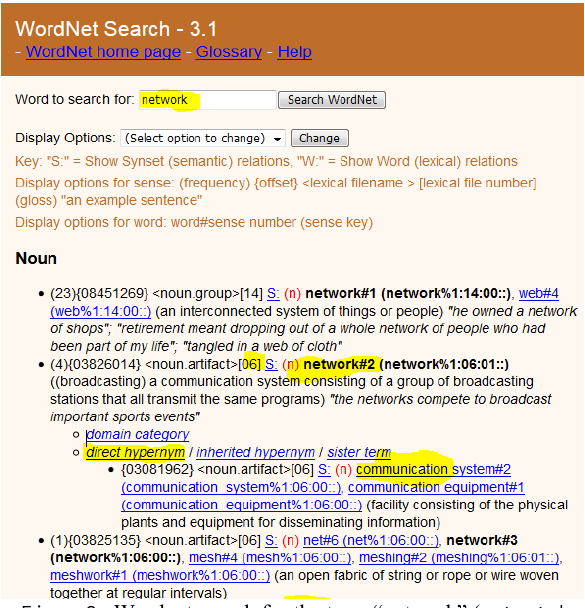
Figure 2 –Wordnet search for the term “network” (extracted from